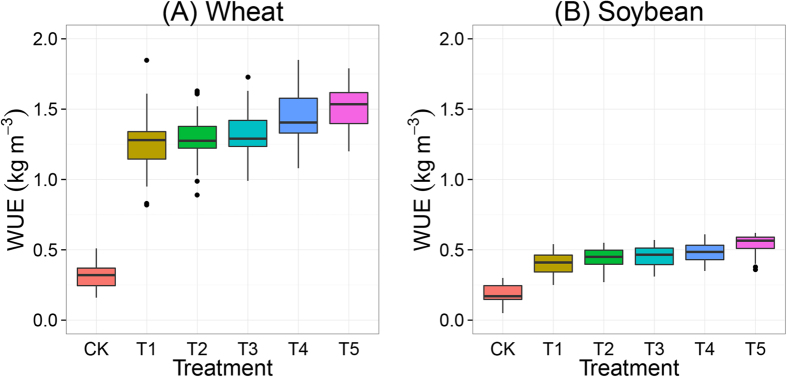
Water use efficiency (WUE) of wheat (A) and soybean (B) as function of fertilization treatments during the period 1982–2012. The treatments are noted as: no fertilization (CK), mineral NPK (T1), NPK + low rate of straw (T2), NPK + high rate of straw (T3), NPK + pig manure (T4) and NPK + cattle manure (T5). Boxes show 25th and 75th percentiles (i.e. Q1 and Q3). Lines in the boxes show the median values.